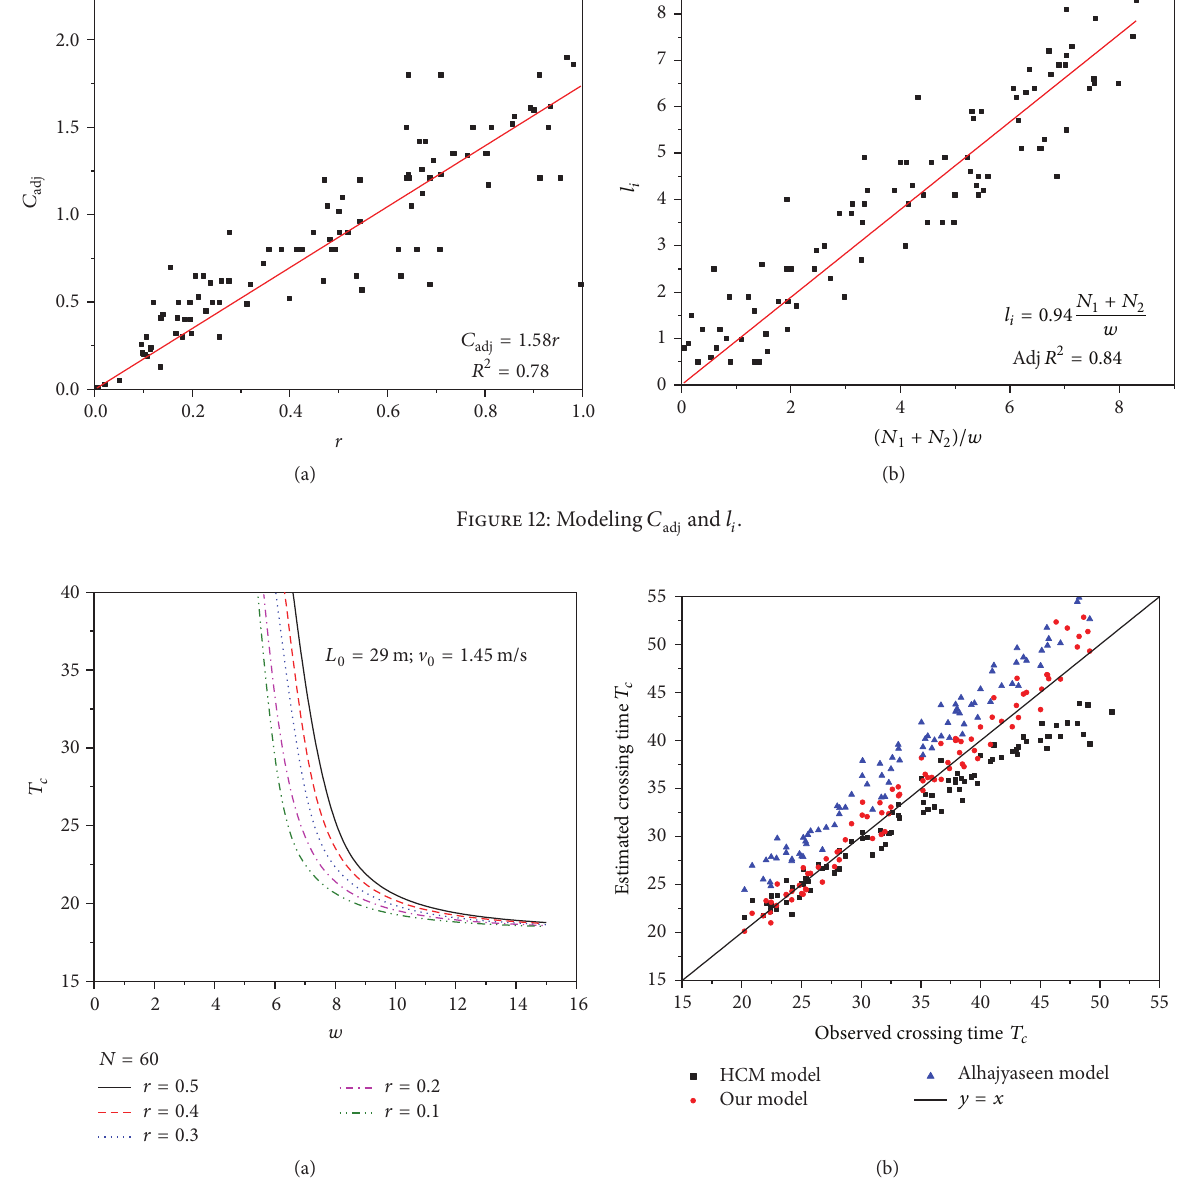
Figure 13: Change in 𝑇 𝑐 with changing crosswalk